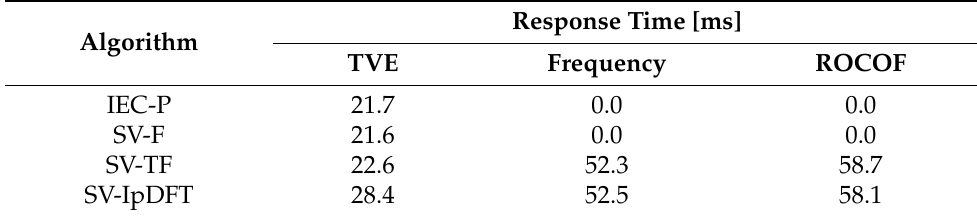
Figure 21. Positive sequence synchrophasor magnitude estimation, 10% amplitude step. Table 1. Response times for + 10% magnitude step